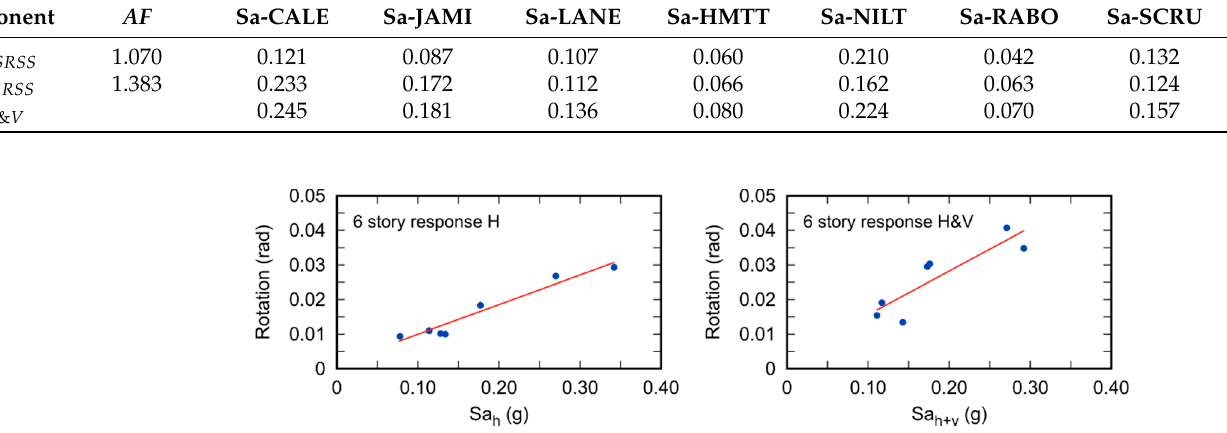
Figure 13. Rotation as a function of Sa for the 6-story building for beams studied in Figures 7 and 8; left for the horizontal component, right for the horizontal plus vertical component.